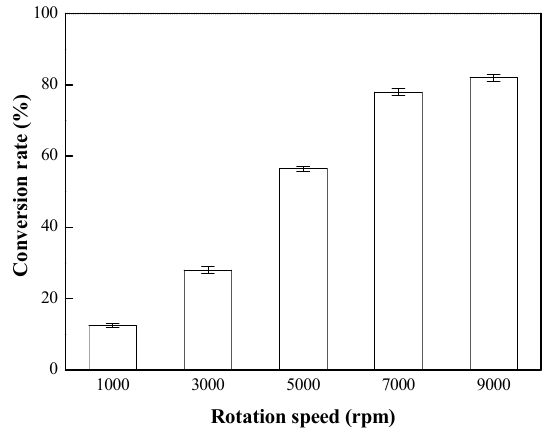
Figure 4. Effect of rotation speed on the transesterification reaction. Reaction condition: methanol/oil molar ratio 6:1, catalyst amount 4 wt %, reaction temperature 65 °C, reaction time 60 min, rotation speed 1000–9000 rpm.